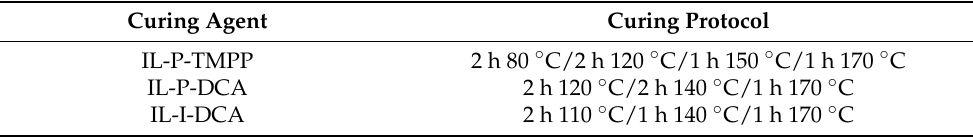
Table 1. Curing protocol used with each IL. Curing